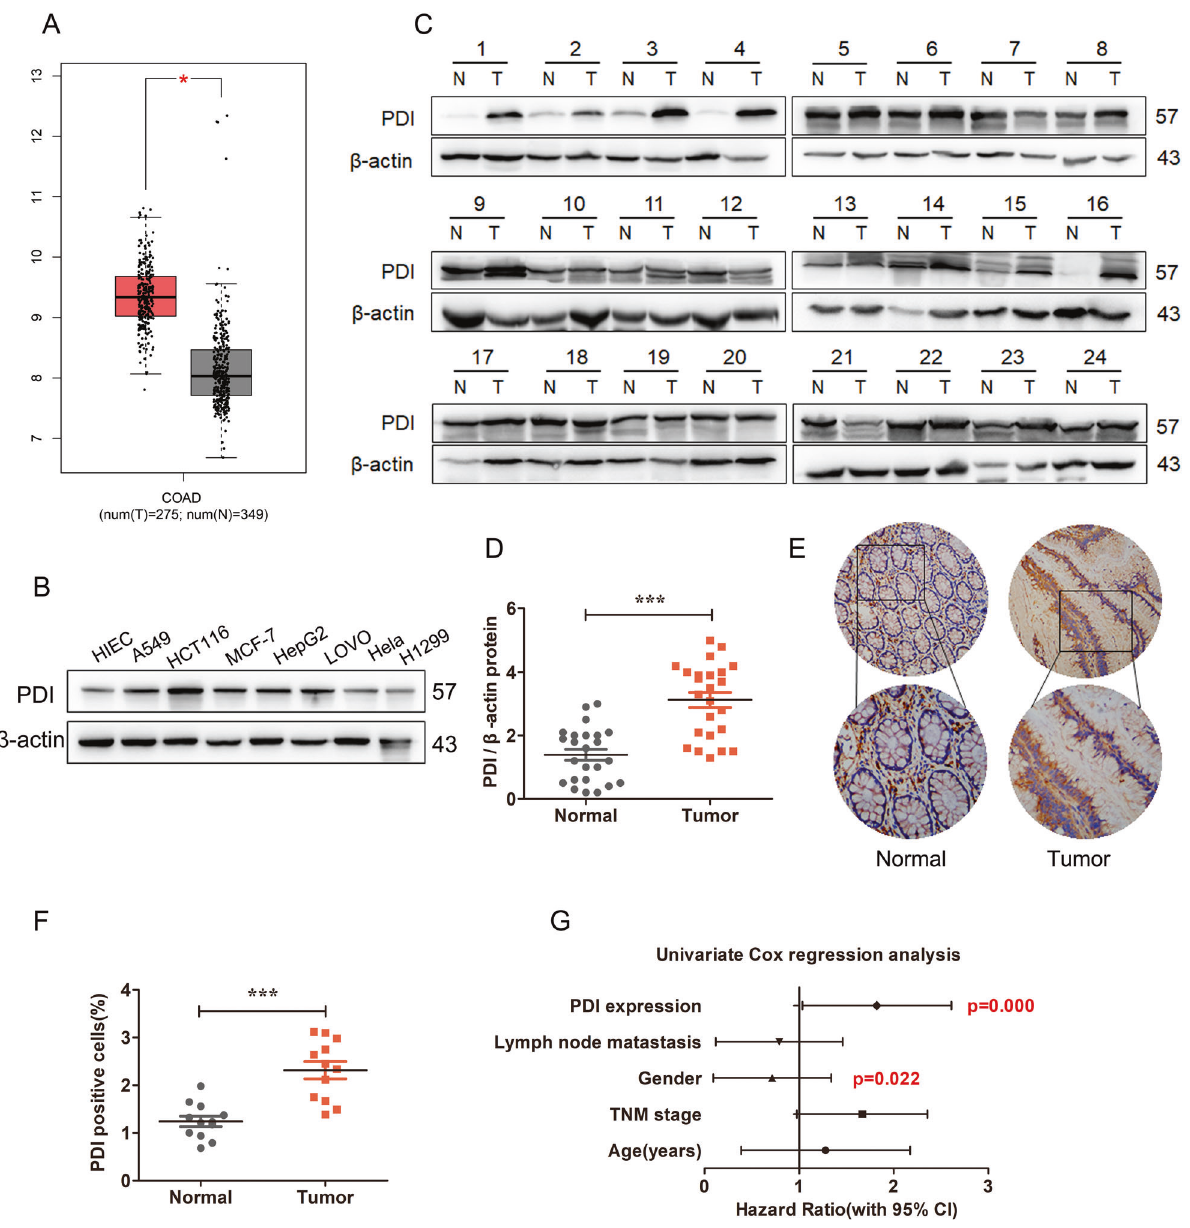
Fig. 1 PDI is elevated in human colorectal cancer tissues and is associated with poor prognosis. A TCGA database was used to analyze the expression of PDI mRNA in CRC tissue (T) and normal tissue (N). B Expression of PDI protein in normal intestinal epithelial and tumor cells. C , D The level of PDI protein in 30 pairs of colorectal cancer tissues (T) and paired adjacent normal tissues (N) was analyzed by western blot ( C ). Quanti fi cation of protein levels ( D ) was normalized to those of β -actin. E , F Represent immunohistochemically staining ( E ) and IHC score ( F ) of PDI expression in CRC and adjacent normal tissues. Original magni fi cation, ×40 (outside) or ×400 (inset). Scale bar = 50 μ m. G Forest plots for univariate analysis of the correlation between clinicopathological features of colon cancer and mortality. Data are presented as the mean ± SD (*** P < 0.001 by Student ’ s